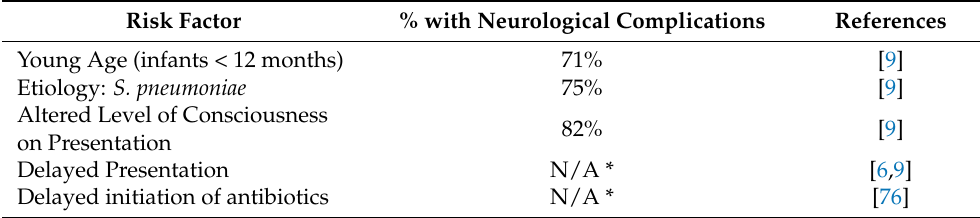
Table 3. Risk factors for developing neurological complication in Bacterial